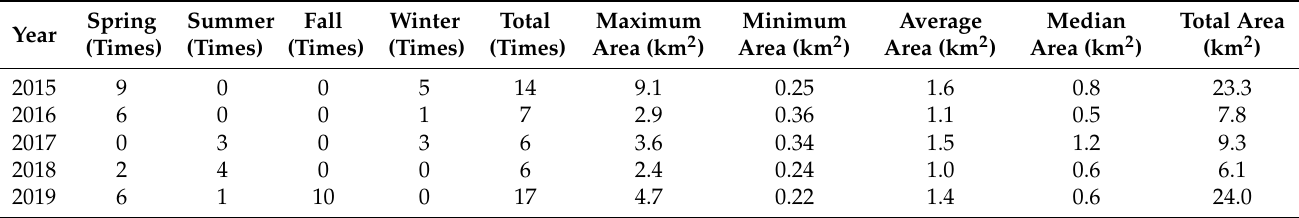
Table 3. Statistical data for delineated oil slicks in the Beibu Gulf.